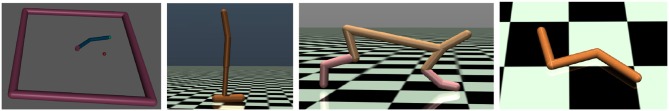
Environments for the Robot Control in State Space: “Reacher,” “Hopper,” “HalfCheetah,” and “Swimmer”.